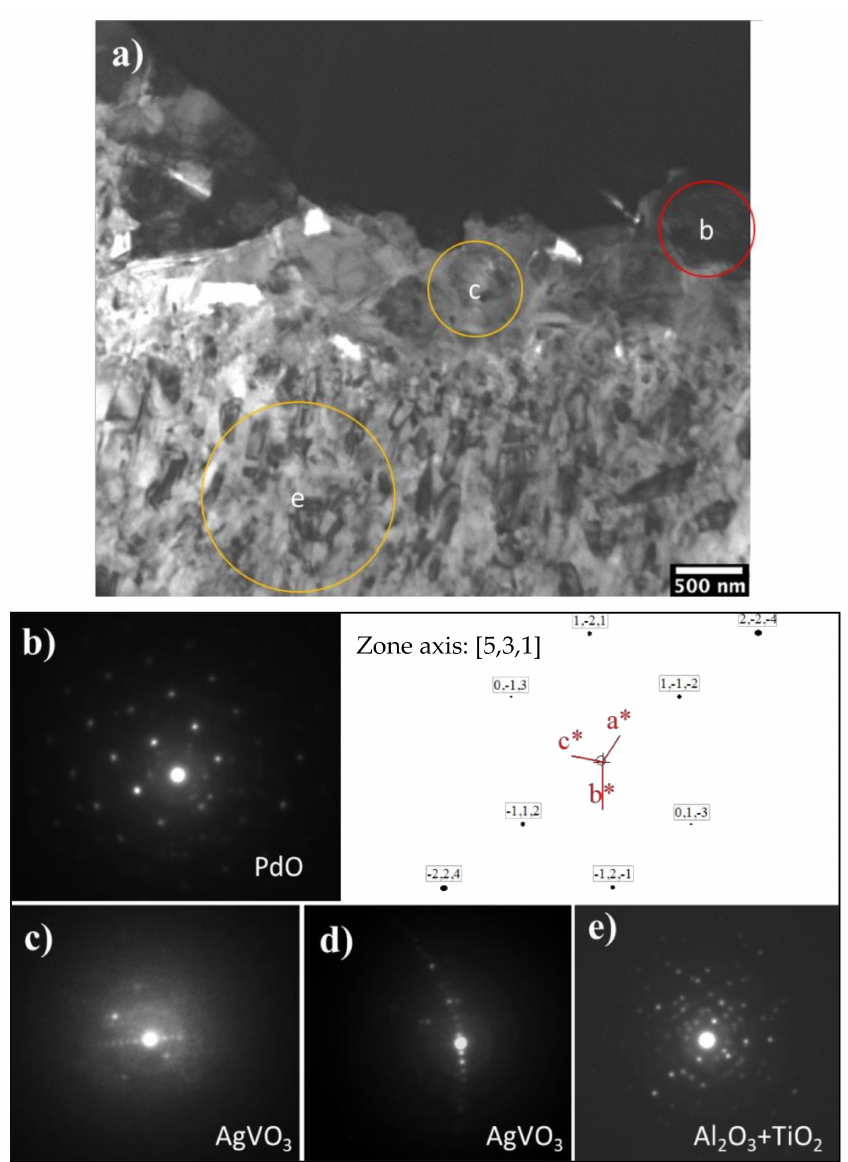
Figure 7. ( a ) BF-TEM of C3T660-10PdAg and corresponding SAD patterns. Region b corresponds to ( b ), region c corresponds to ( c ) and ( d ), and region e corresponds to ( e ). Areas of b, c, e are denoted in ( a – e ) indicate phases of PdO, AgVO 3 , TiO 2 and Al 2 O 3 as labelled. SAD patterns taken from the granular grains were identified as a PdO phase, evi- denced by a B = [531] pattern shown in Figure 7a,b, which is consistent with the XRD peaks indexing of PdO in Figure 5. No Ag oxides could be identified from the diffraction patterns taken from the granular grains. As the EDX detected co-existing of Ag, 2 wt%, with Pd in the granular grains (see Figure 4d), a PdO-like oxide with some of the Pd being